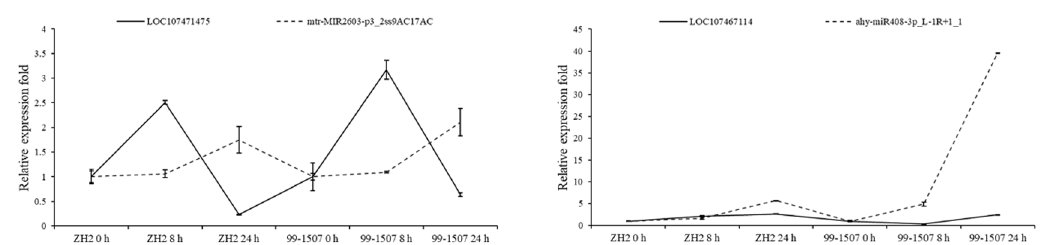
Figure 8. Expression correlation between miRNAs and their targets at six different durations of Al treatment. The thin and thick lines indicate miRNAs and accordingly targets abundance, respectively. To standardize RNA quantity for evaluating relative expression levels, U6 and actin were used as the internal reference genes of miRNAs and their targets, respectively. The expression level at 0 h in each sample was used as reference state, which was set to 1, and fold change values were shown here.